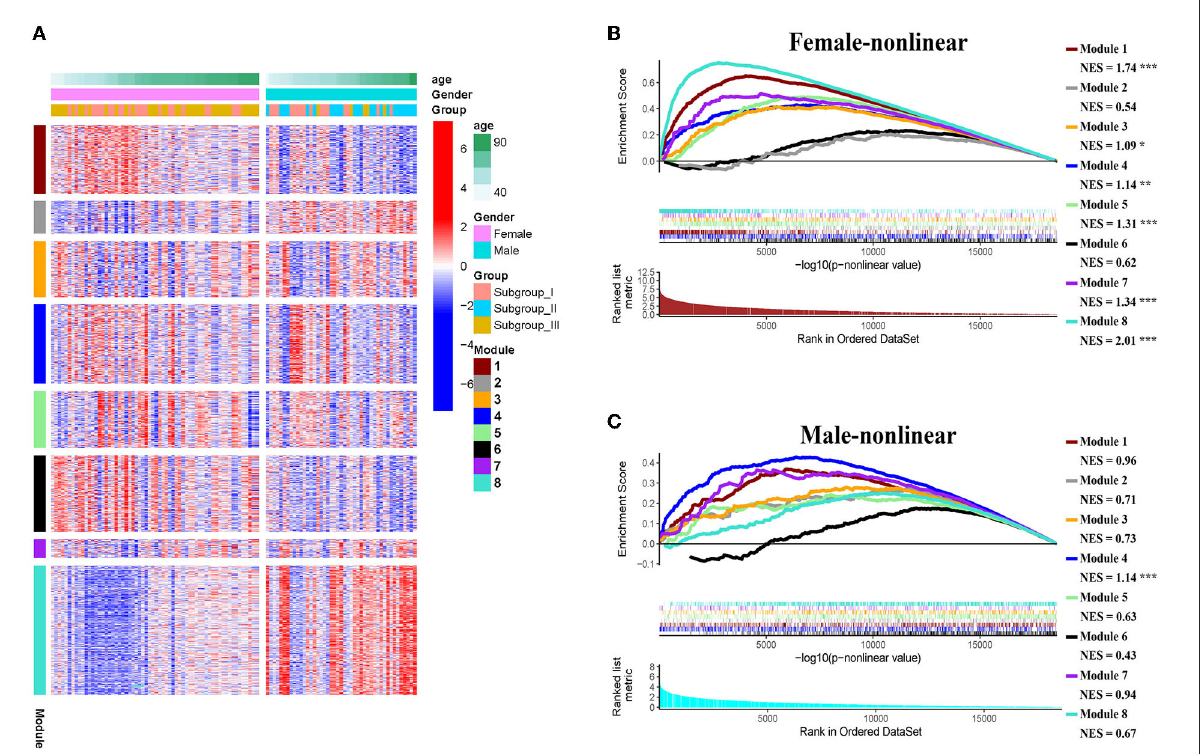
FIGURE6 (A) Heatmap showing association of gender-specific distribution of age with the expression of subgroup-specific genes in each module. Red and blue indicate upregulation and downregulation, respectively. Samples were ordered by increasing age in each gender. (B,C) The enrichment plots of the restricted cubic spline-GSEA showing the significance of the non-linear relationship between all normalized expression of genes in each module and log-transfer age in female patients (B) and male patients (C)